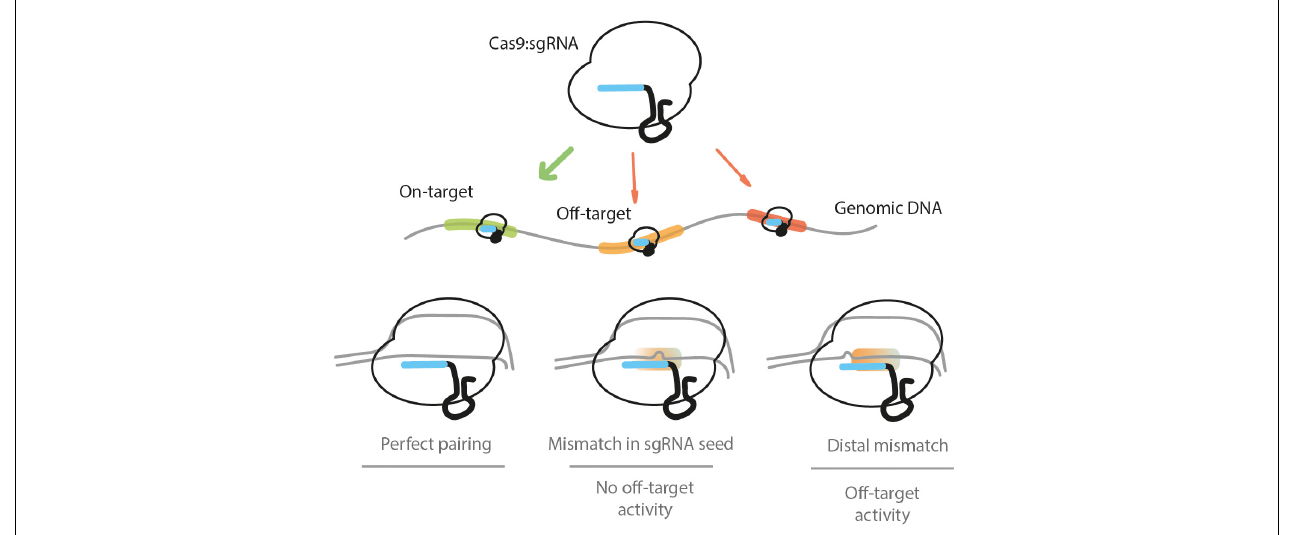
FIGURE 1 | The Cas9:sgRNA ribonucleoprotein complex targets the genomic DNA when present in the cell nucleus. It will target PAM-adjacent sequences and may encounter several potential recognition sites. If there is a perfect base pairing between the target DNA and the sgRNA, a DSB is induced by Cas9. If there is a mismatch between the sgRNA and the DNA sequences present within the first 7–12 bp (proximal to the PAM) segment, the base pairing will not be sufficient to induce a DSB. If one or more mismatches between the DNA and sgRNA sequences are found in the PAM-distal (5 (cid:48) end of the sgRNA) nucleotides, a DSB can be induced by Cas9, leading to off-target activity. The scenario of sgRNA sequence-independent off-targets is not